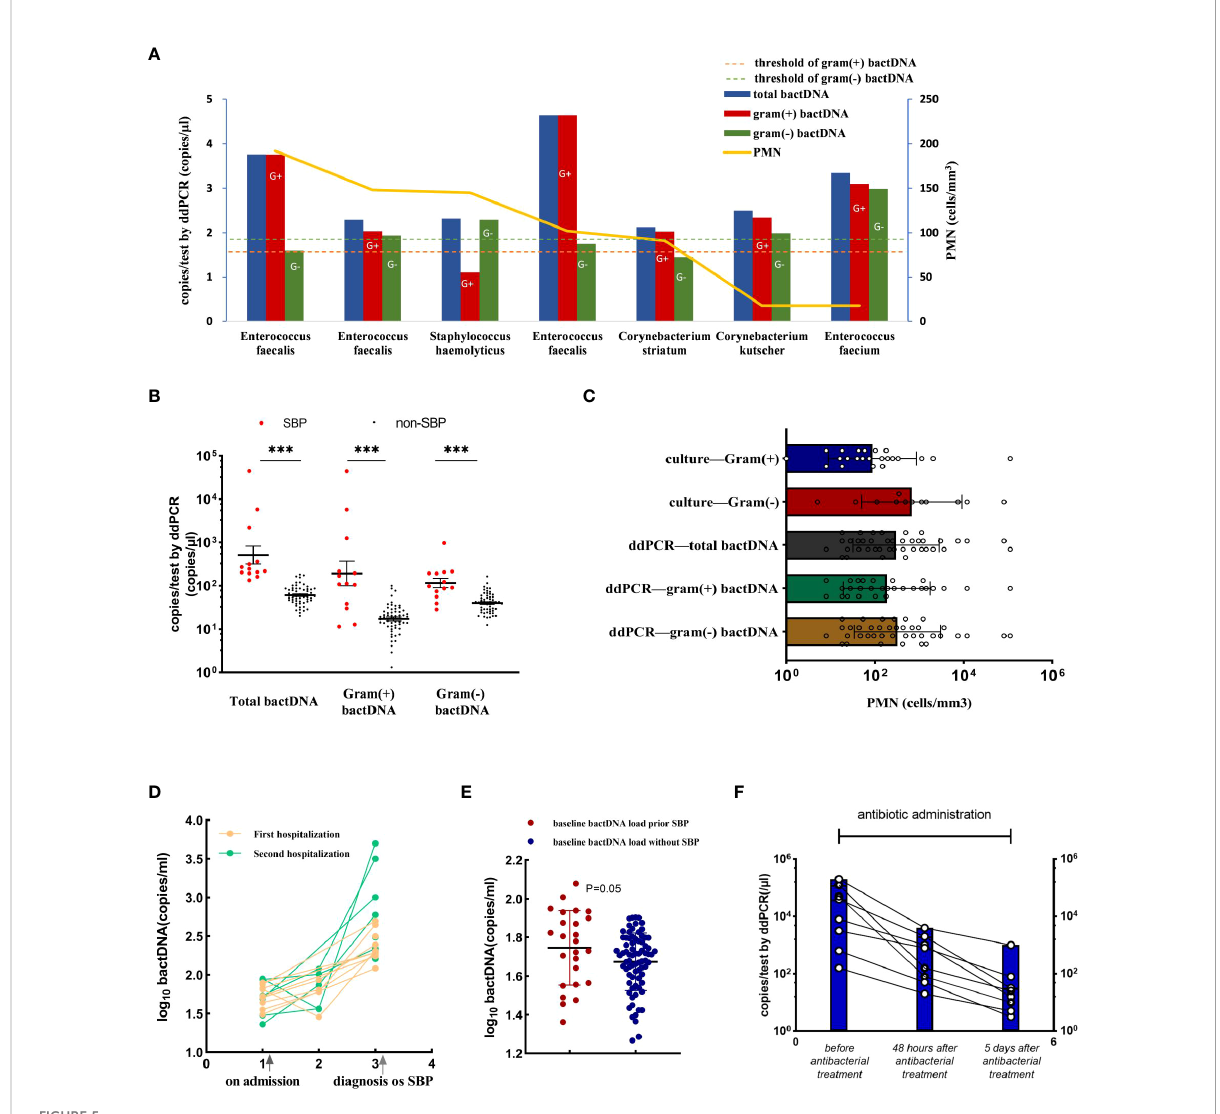
FIGURE 5 Accuracy of ddPCR testing in ascites and the bactDNA quantitation in patients with PMN < 250 cells/mm 3 . (A) The bactDNA load and PMN counts from seven patients diagnosed as SBP with PMN < 250/mm 3 . (B) Patients with PMN < 250/mm 3 [SBP (n = 13) and no-SBP (n = 150)]. (C) PMN counts of different bacteria species in 191 samples based on culture and ddPCR. (D) Nine ascites without infection on admission developed SBP during hospitalization. Five patients were readmitted due to SBP diagnosis within 3 months, and fi ve patients were readmitted due to SBP diagnosis within 3 months. (E) Baseline bactDNA load prior and without SBP development. (F) Dynamic changes of bactDNA load using ddPCR method in patients with SBP over time precede antibacterial treatment, 48 h and 5 days after antibacterial treatment (n = 8). PMN, polymorphonuclear; SBP, spontaneous bacterial peritonitis. ***P <